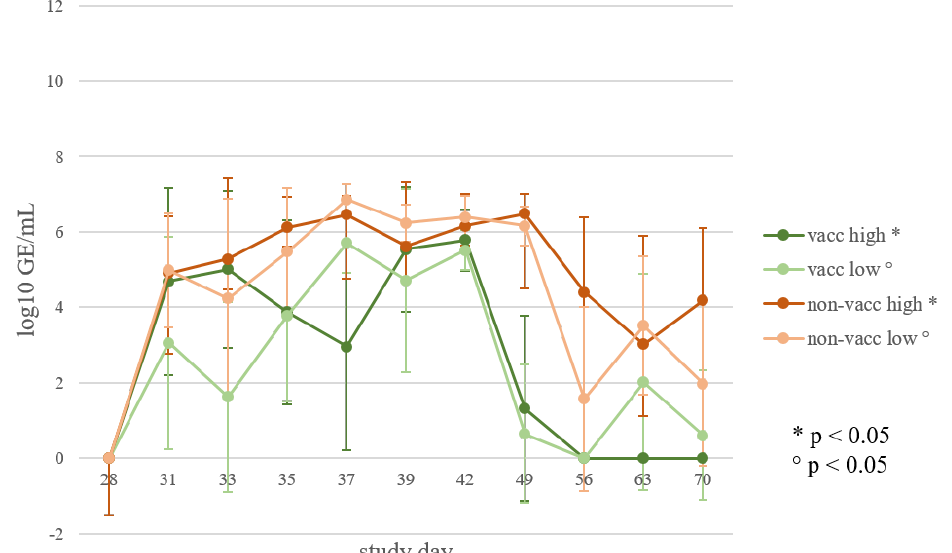
Figure 7. Viral load in oral swabs. Mean and standard deviation of qRT-PCR results from oral swabs (log 10 GE/mL) of each infected group (vacc high: vaccinated, high dose [10 5 TCID 50 /dose] infected; vacc low: vaccinated, low dose [10 3 TCID 50 /dose] infected; non-vacc high: non-vaccinated, high dose infected; non-vacc low: non-vaccinated, low dose infected) at different time points after infection (study days). Significant differences in the AUC values are indicated ( p < 0.05).